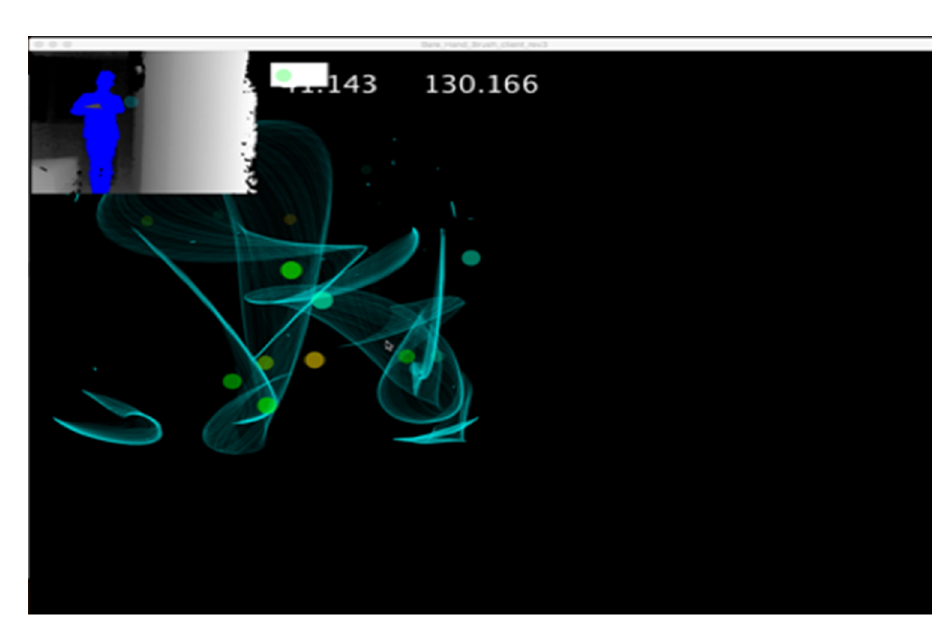
Figure 5. Black screen (canvas) and green-ink spray traces.